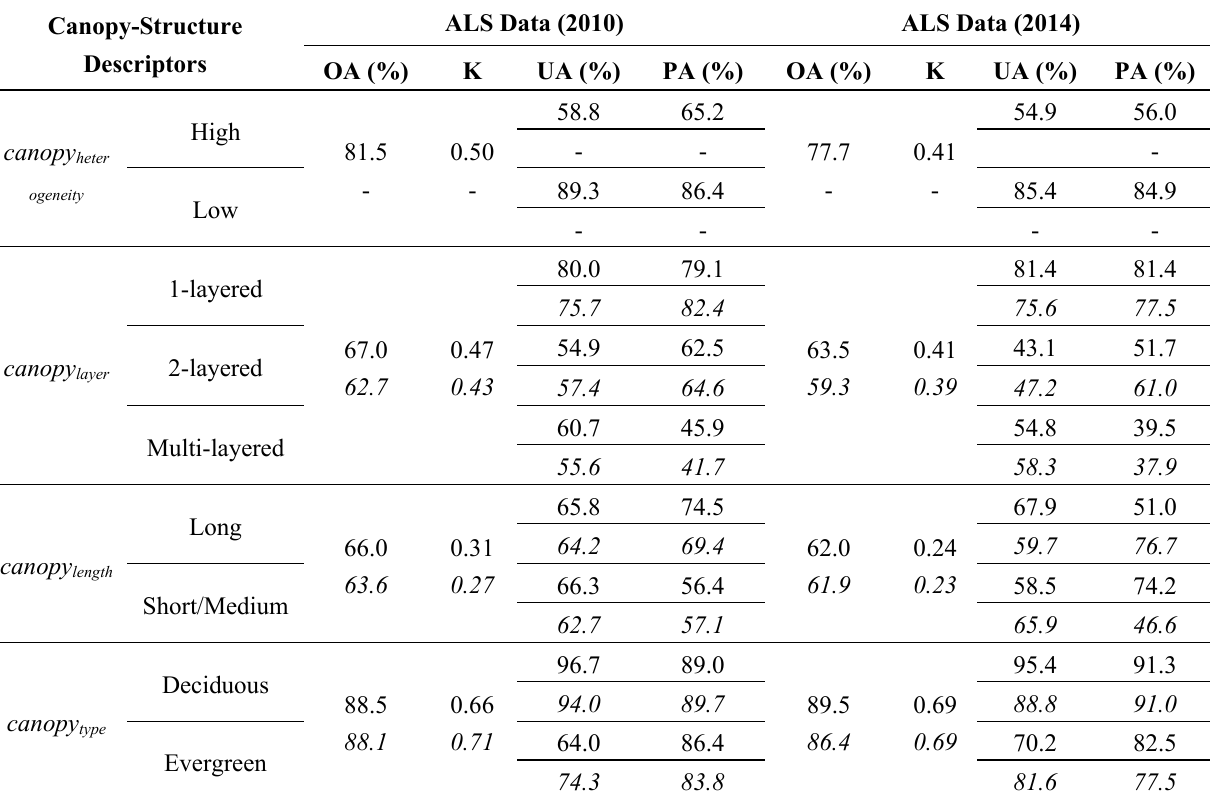
Table 3. Accuracy assessment of the canopy-structure descriptors for the Laegern site. We use the accuracy metrics “overall accuracy” (OA), “user’s accuracy” (UA), “producer’s accuracy” (PA), and the “Kappa coefficient” (K). Resulting values in italics represent results obtained from stand